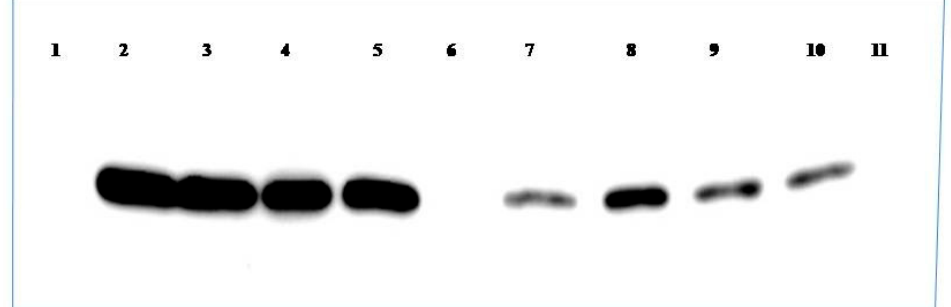
Figure 3. Western blot analysis of purified ToLCNDV-Rg-CP and ToLCNDV-Rg isolate infected plant sample with the ToLCNDV-Rg-CP-PAbs. Lane 1: Blank E.coli BL21 strain; Lanes 2–5: Purified ToLCNDV-Rg-CP expressed in E. coli .; Lane 6: Crude plant extract from healthy ridge gourd; Lanes 7–10: Crude plant extract from ToLCNDV-Rg infected ridge gourd; Lane 11: pET22-NH+ E.coli BL21 strain.